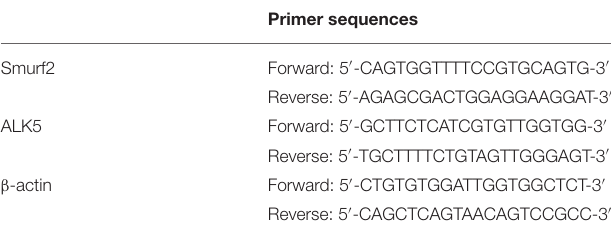
TABLE 1 | Primer sequences used for